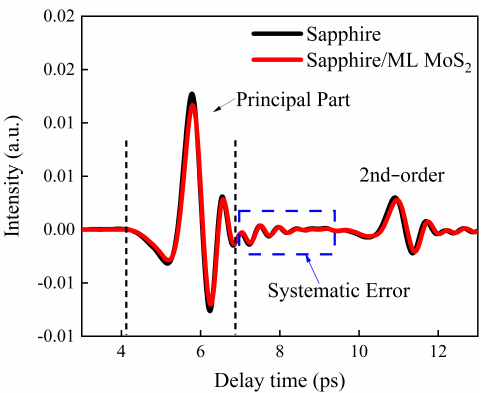
Figure 2. The waveforms of the THz pulses transmitted through the sapphire substrates and ML MoS 2 /sapphire. The dashed blue box is a systematic